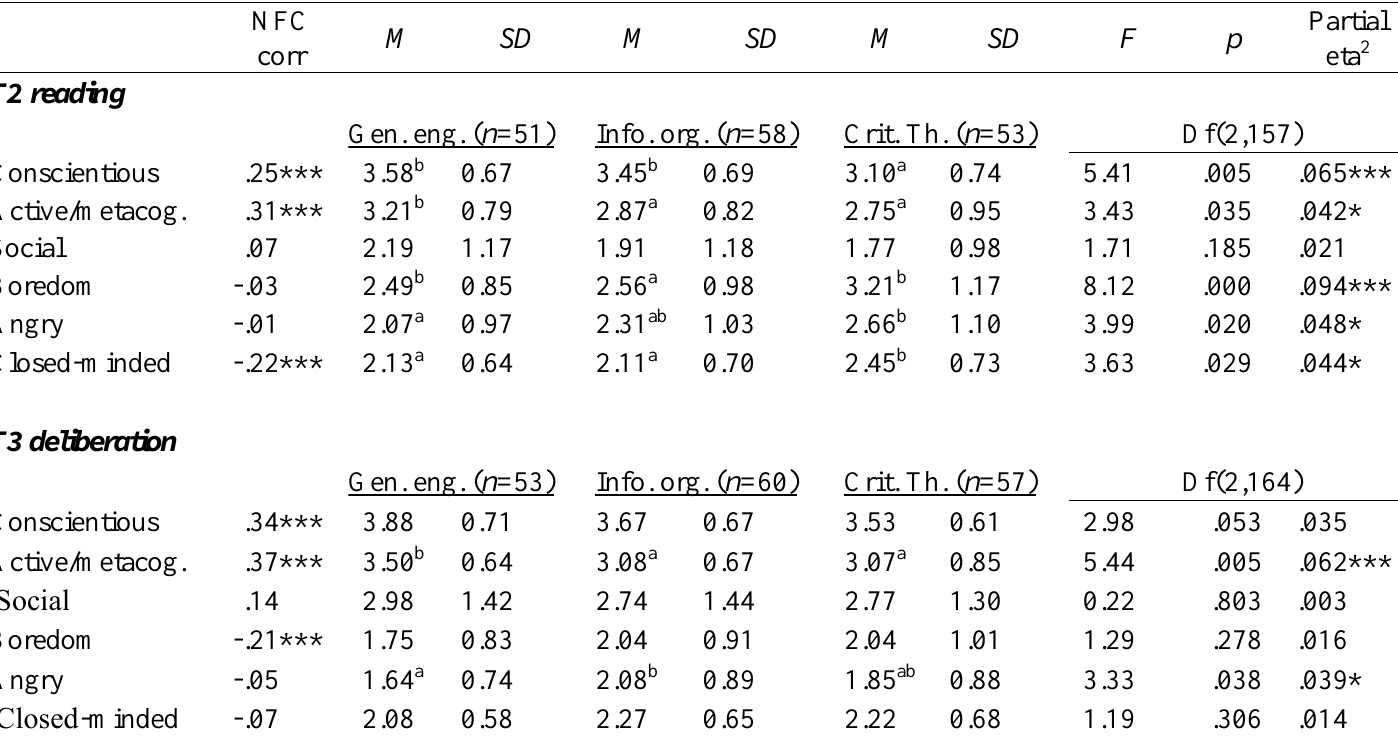
Study 1 univariate follow-ups examining the impacts of experimental conditions on engagement states during T2 reading and T3 deliberation activities